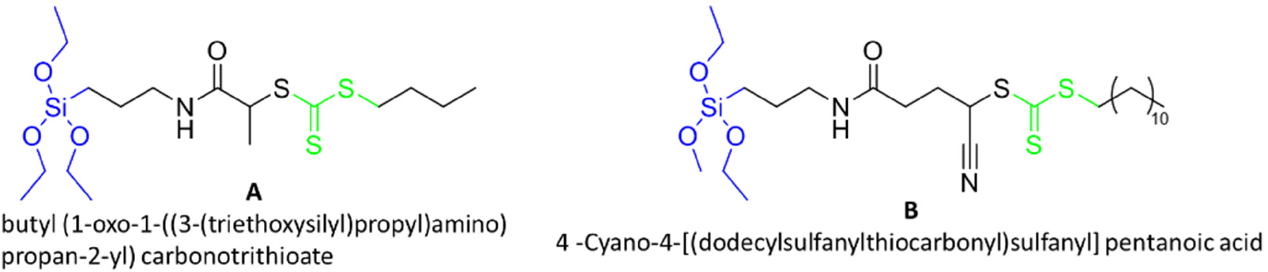
Figure 14. RAFT agents (green) with organosilane anchor moieties (blue).